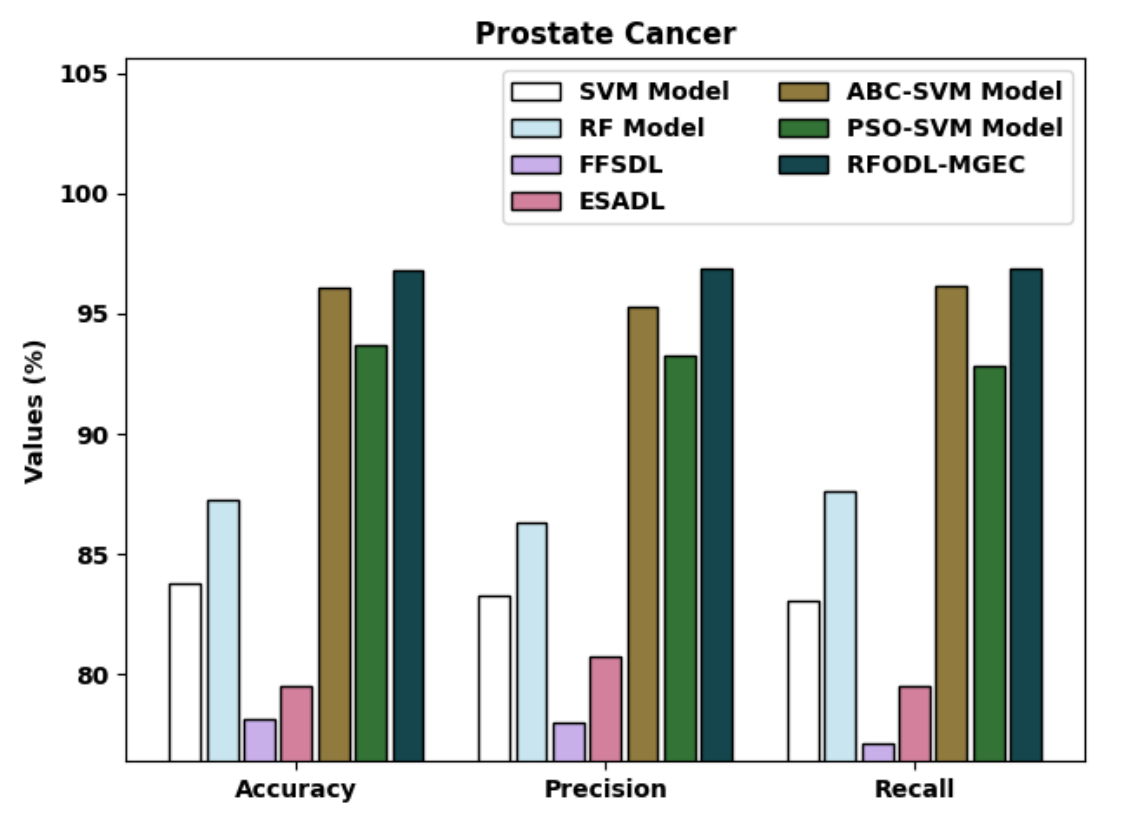
Figure 12. Comparative analysis of RFODL-MGEC technique with prostate cancer dataset.